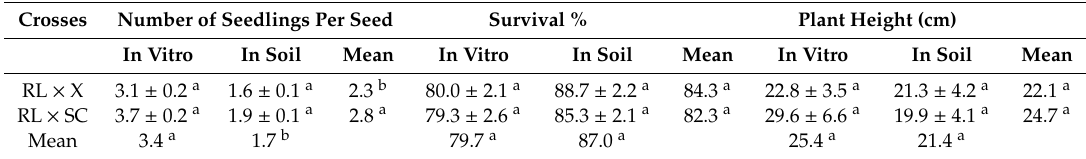
Table 6. Number of seedlings per seed, survival percent, and plant height (cm) obtained from two culture conditions.